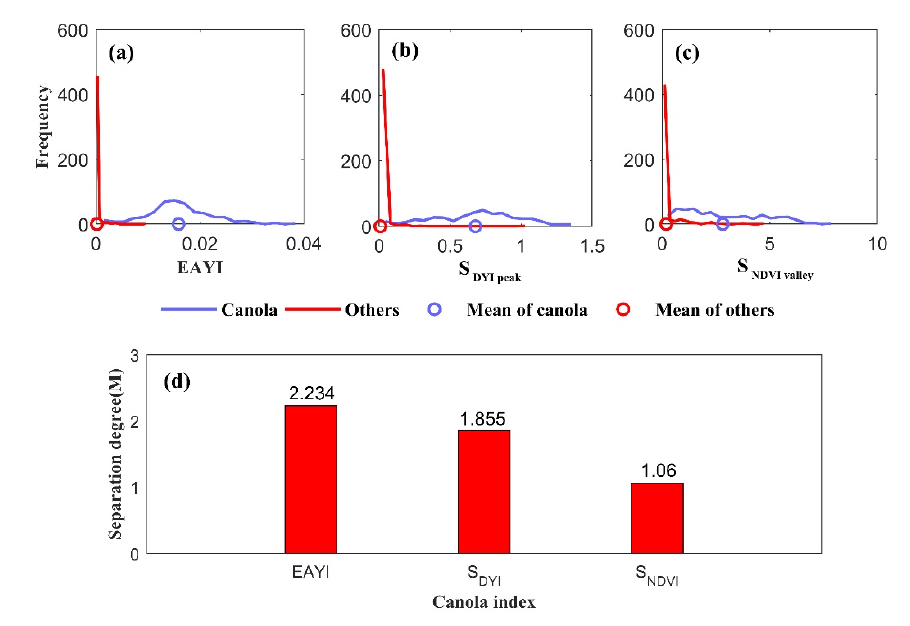
Figure 12. Histograms of ( a ) EAYI, ( b ) Area of DYI peak, ( c ) Area of NDVI valley for canola and other land-cover type samples. ( d ) Separation degree of EAYI, area of DYI peak and area of NDVI valley.